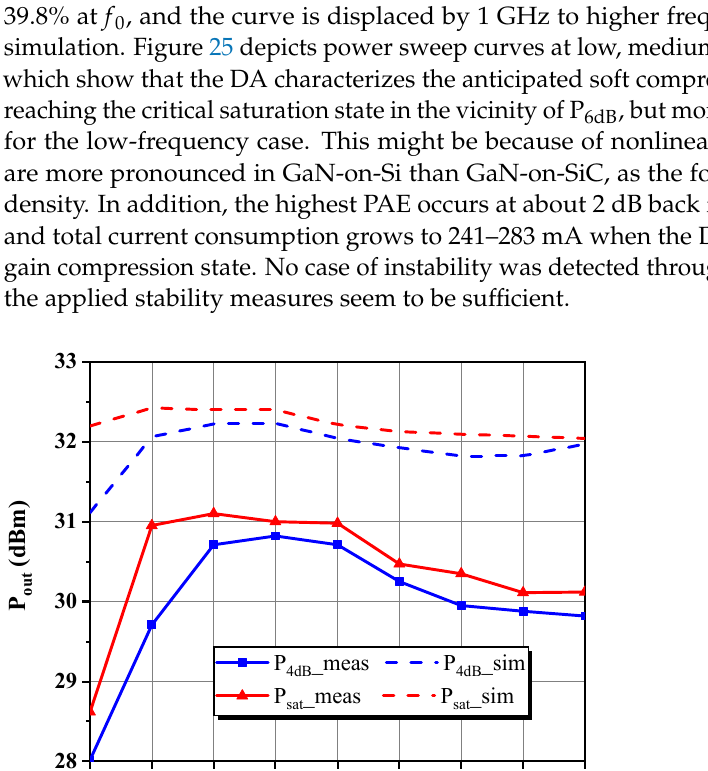
Figure 24. Measured and simulated PAE at P 4dB versus frequency. Figure 25. Measured P out , PAE, and gain behaviors with respect to P in at three equally spaced fre- quencies across the objective band.